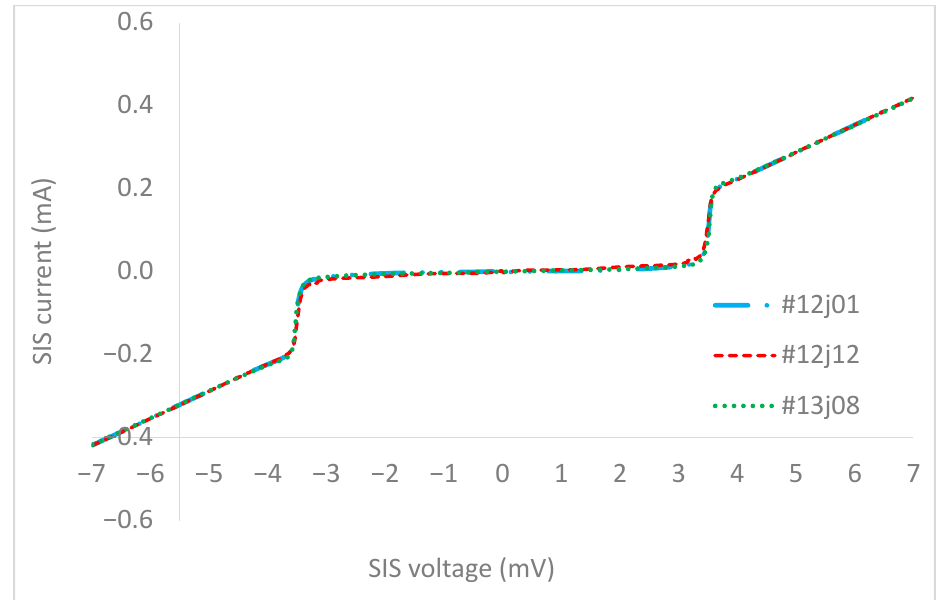
Figure 10. I–V characteristics of Nb–AlN–NbN junctions of the same size, fabricated using EBL and plasma chemical etching in an SF 6 atmosphere, located both on different substrates and on different parts of the same substrate: SIS #12j01 (area 0.732 µm 2 with a current density of 25 kA/cm 2 , R n = 15.22 Ω , R j / R n = 38.1, V g = 3.51 mV); SIS #12j12 (area 0.735 µm 2 with a current density of 23.2 kA/cm 2 , R n = 15.16 Ω , R j / R n = 13.2, V g = 3.49 mV); SIS #13j08 (area 0.743 µm 2 with a current density of 24.5 kA/cm 2 , R n = 15.44 Ω , R j / R n = 23.4, V g = 3.52 mV).